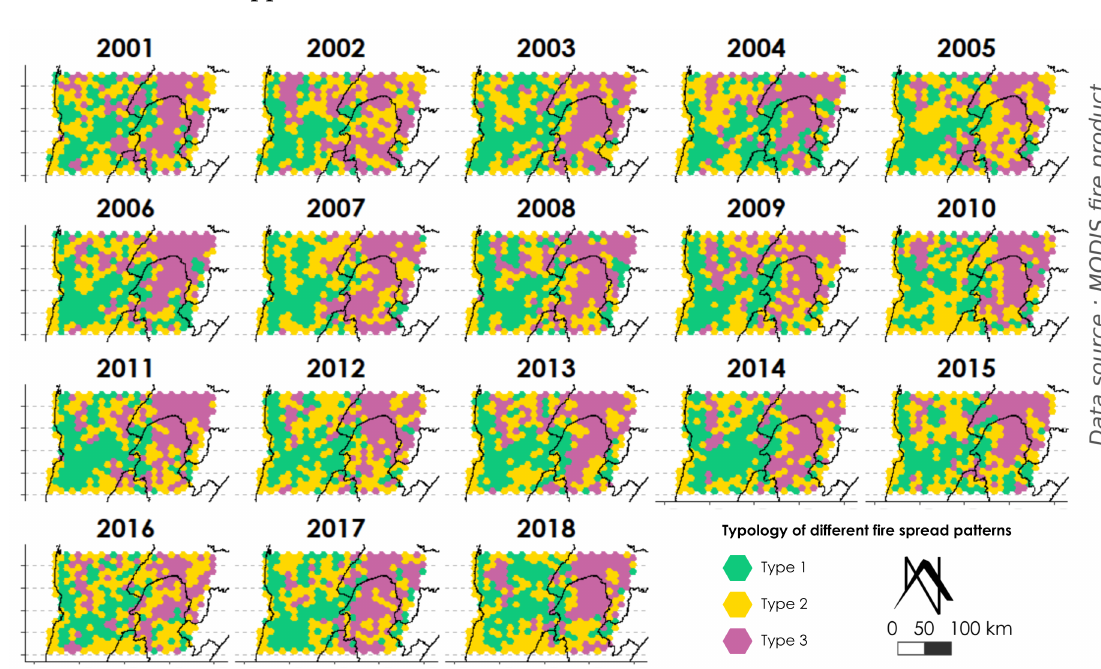
Figure A4. Mapping the residuals for each year between 2001 and